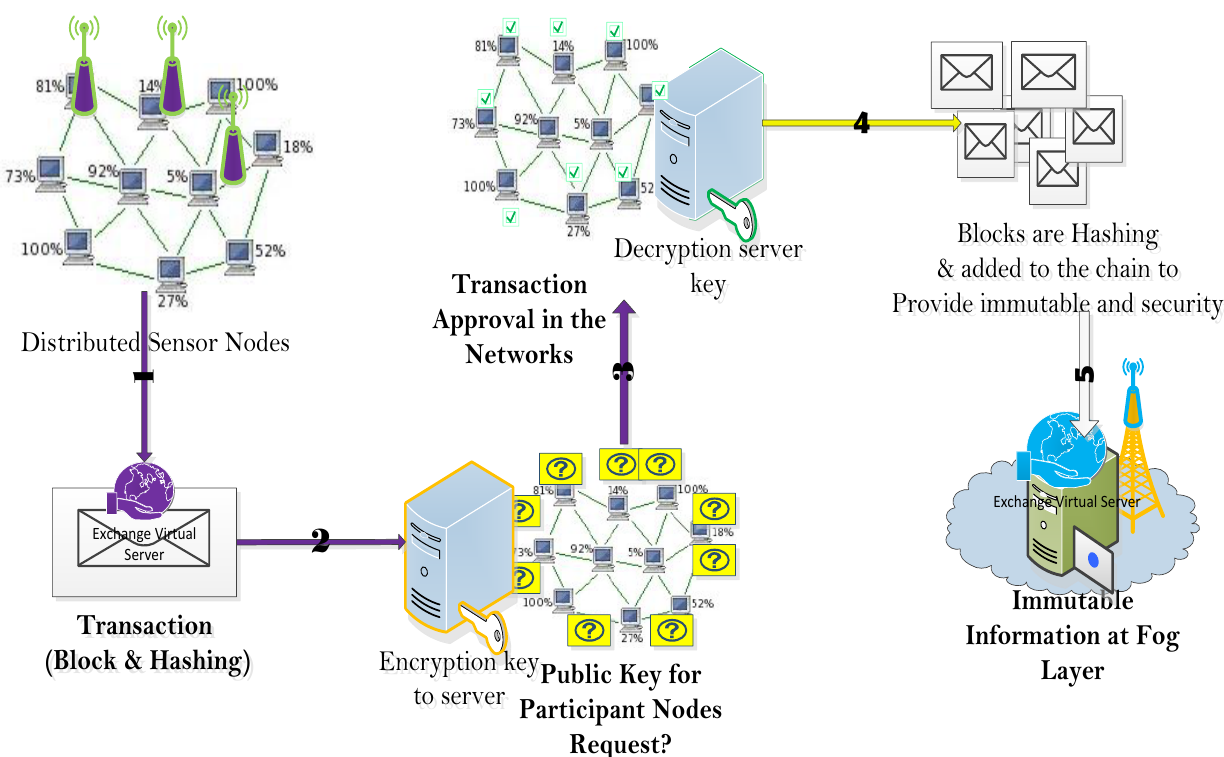
Figure 6. Blockchain transaction model of the distributer WSN. The decentralized ledger protocol (DLC) is a developed database that helps to admin- ister the transaction through the network chain with consensus agreement on the record updates without permission of a central authority or third-party negotiation. This DLC- database provides a timestamp with a unique credential signature to make the transaction history in the chain immutable. A sequence diagram of a proposed medical data security model at the fog layer is shown in Figure 8, and the procedure is discussed as